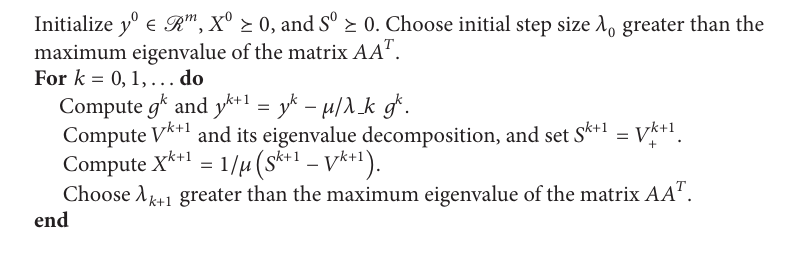
Algorithm 1: Linearizing alternating direction augmented Lagrangian algorithm for